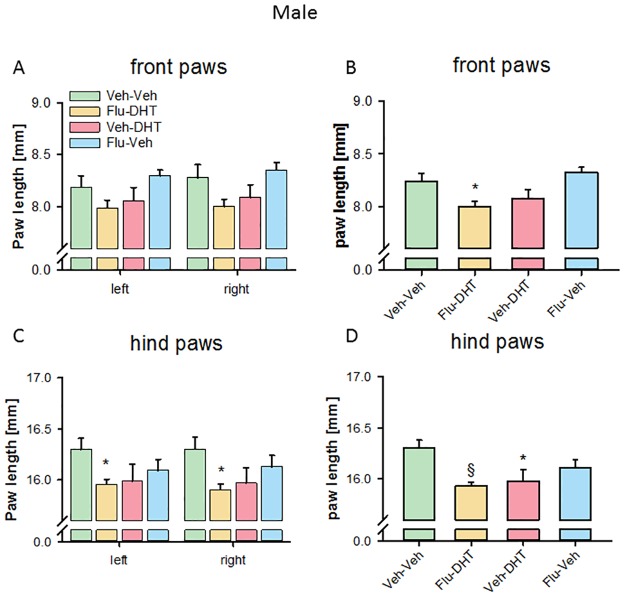
Shorter paws in males prenatally treated with Flutamide-Dihydrotestosterone.(A) Paw length of the left and right front paw. (B) Paw length of pooled (left + right) front paws. (C) Paw length of the left and right hind paw. (D) Paw length of pooled (left + right) hind paws. Data represented as mean ± Standard error of the mean (SEM). * p<0.05 and § p<0.001 compared to control. Veh—Vehicle; Flu—Flutamide; DHT—Dihydrotestosterone.